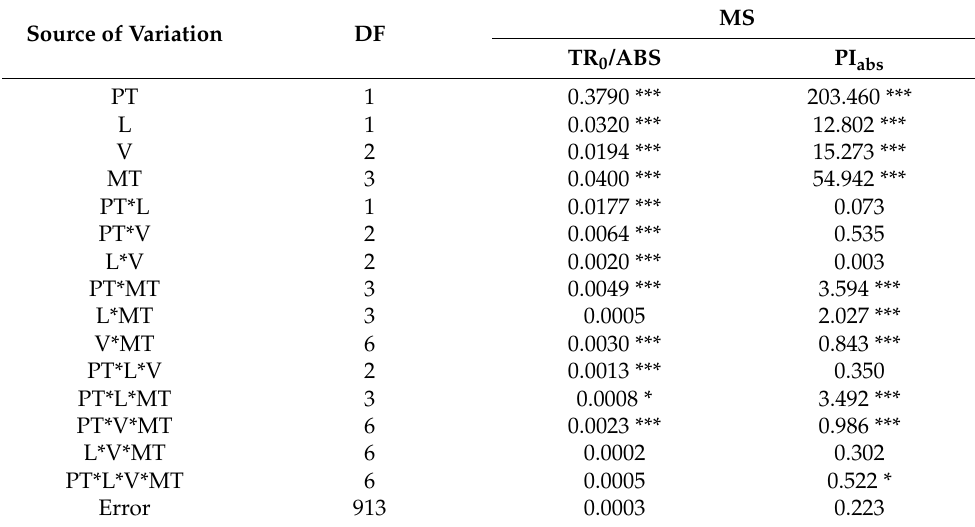
Table 3. Analysis of variance for two chlorophyll fluorescence induction (OJIP)